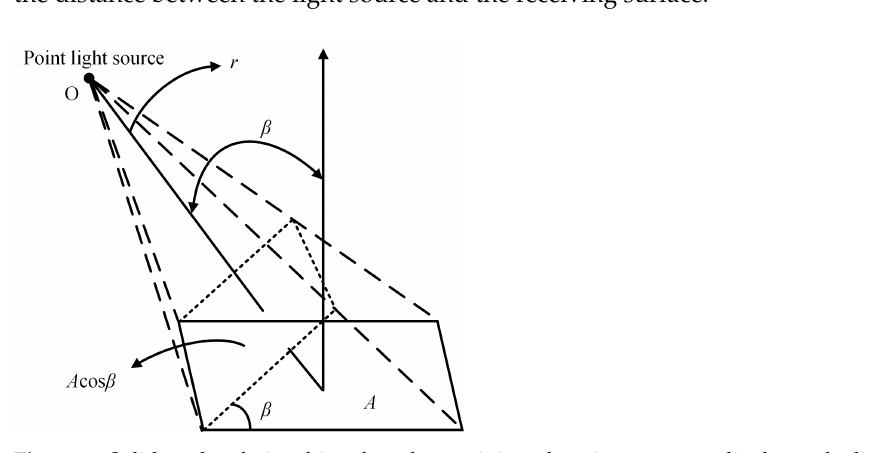
Figure 3. Solid angle relationship when the receiving plane is not perpendicular to the light